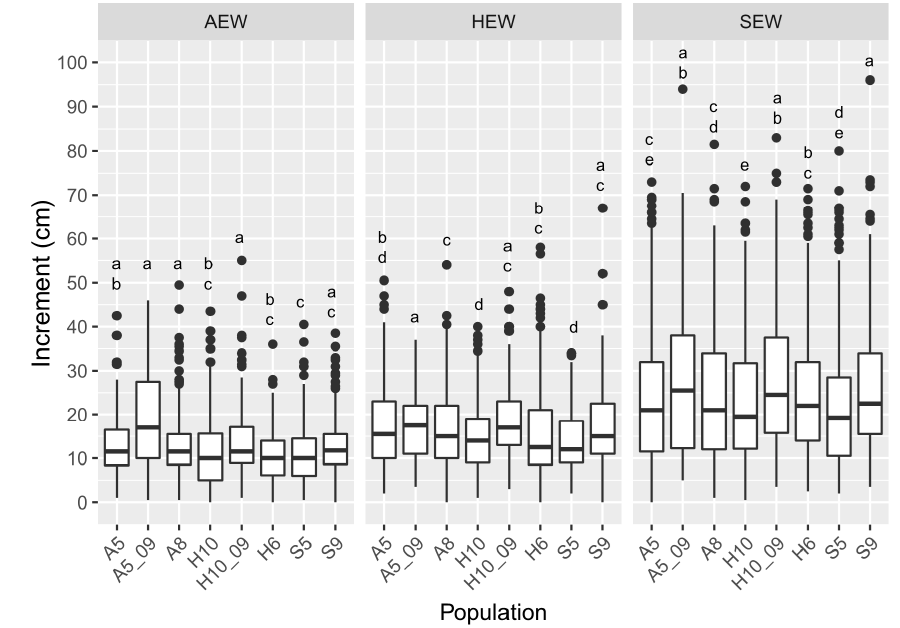
Figure 4. Boxplots of plant height increment from planting (2012) to 2015 for the populations in the three study regions. Different letters indicate significant differences among populations. (Populations from the SEW region: S5 and S9; from HEW: H10, H10_09, and H6; from AEW: A5, A5_09, and A8. For the populations H10 and A5, seeds from 2009 were also available for raising seedlings and are named H10_09 and A5_09, respectively).